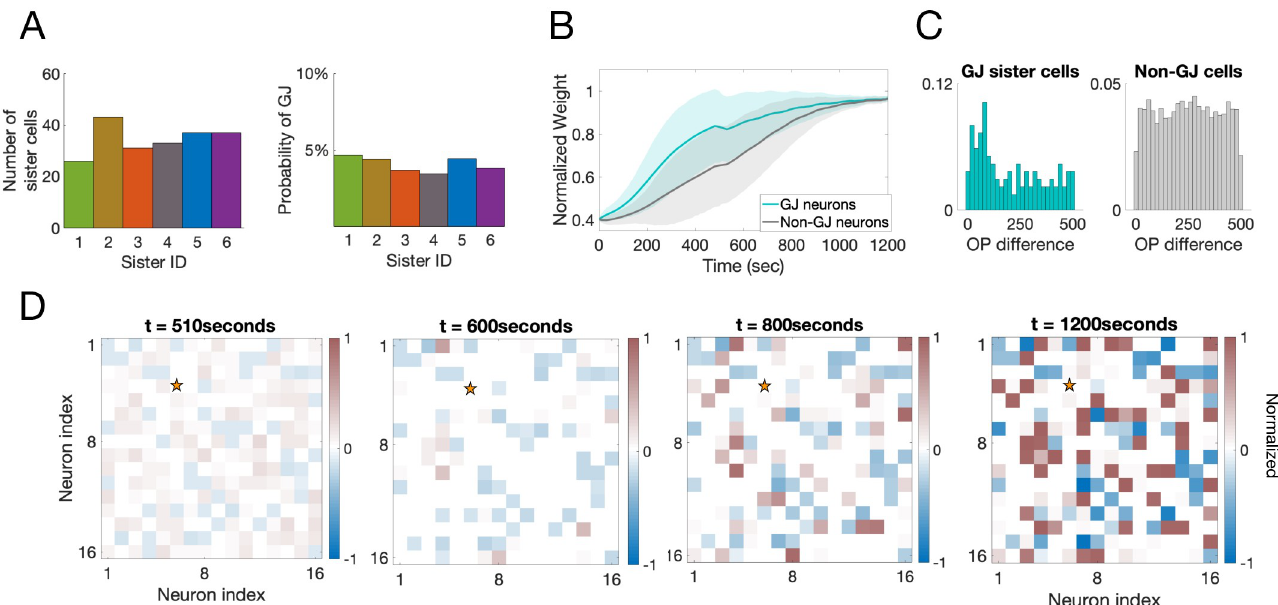
Fig 4. Measurements from a 256-neuron network with all-to-all potential cortical connectivity. A : The number of cells (left) and the probability GJ-coupling (right) within each of the six sister groups. B : The rate of LGN synaptic learning averaged over all GJ-coupled cells (teal) and non-GJ-coupled cells (gray). C : The distribution of differences in OP for GJ-coupled cells (teal) and non-GJ-coupled cells (gray). D : The normalized recurrent cortical weights onto one sample excitatory cell, indicated by a star. Inhibitory weights onto this cell are indicated by negative values and shown in blue while excitatory ones are positive and shown in red. The recurrent connections begin at t = 500 seconds and the entire simulation was run for 1200 seconds.